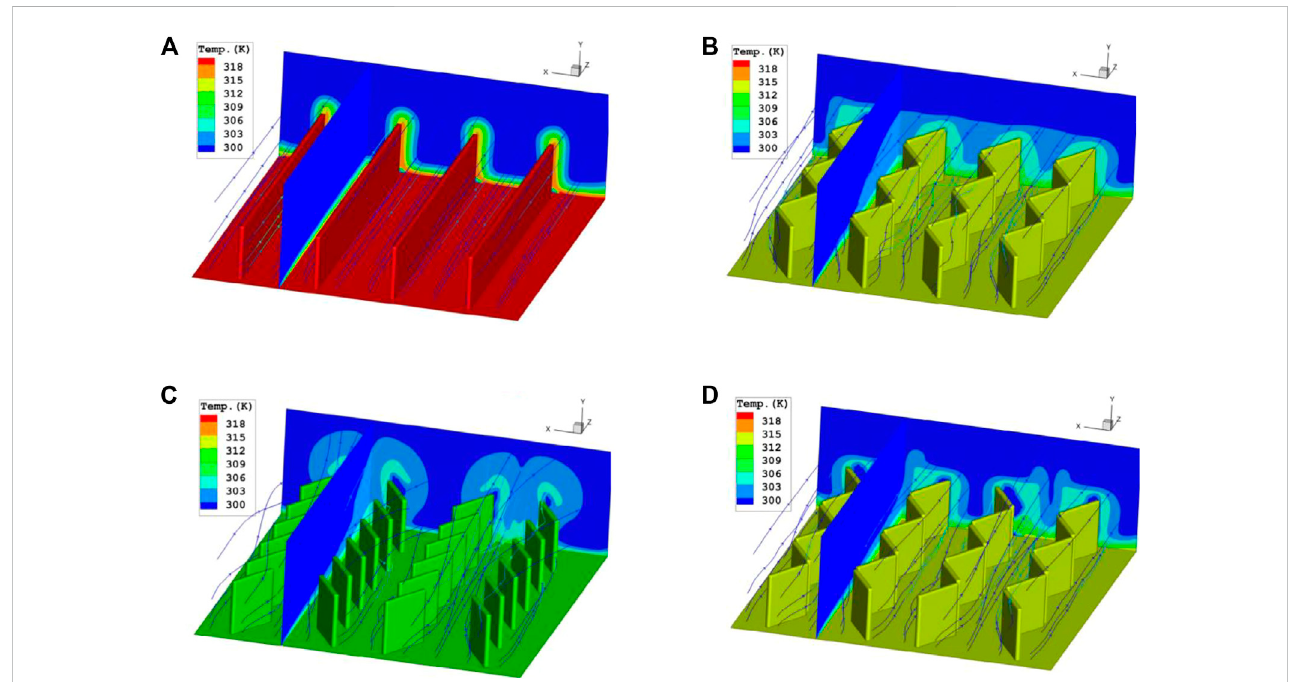
FIGURE 3 Flow stream and temperature distribution on (A) Simple; (B) Model one; (C) Model two; (D) Model 3 (Park et al.,